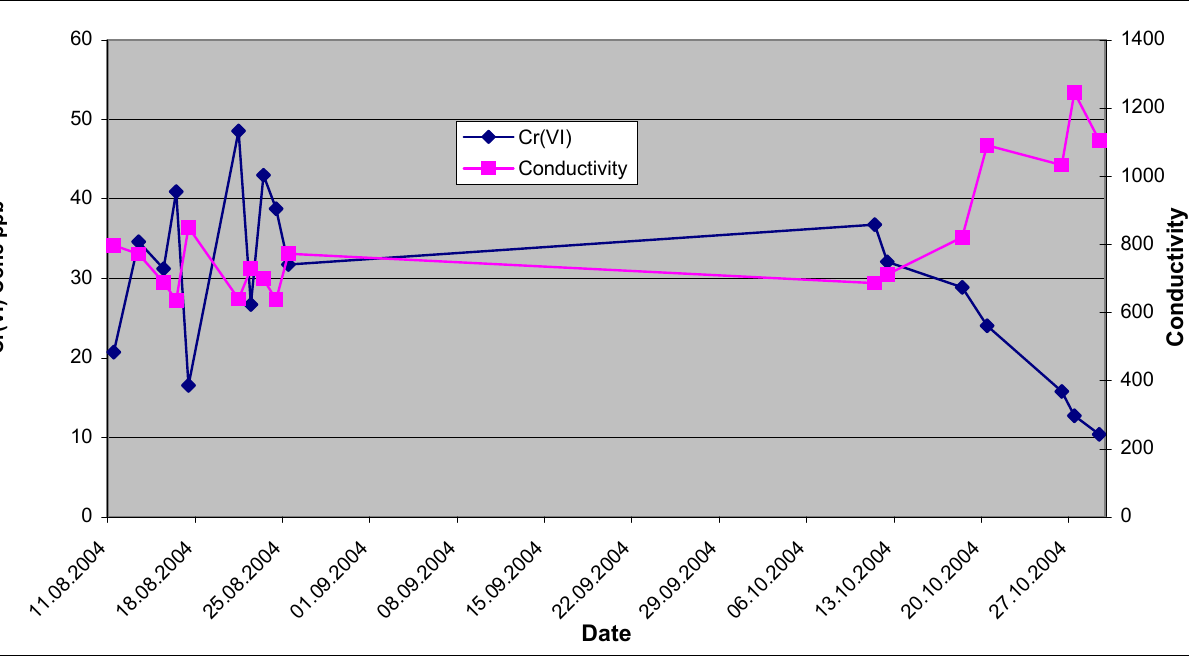
Figure 8. Hexavalent chromium & conductivity for aquifer tube DD-39-3 August 11-October 29,